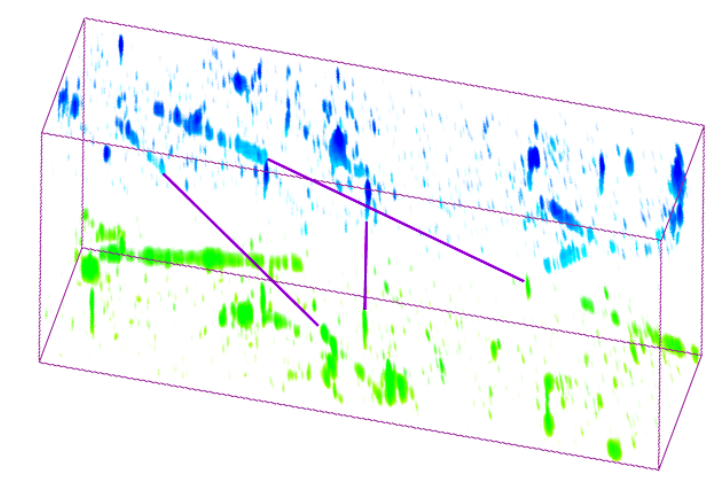
Figure 9. Tomographic data acquired by the microscope for a small volume of 150 µ m × 30 µ m × 300 µ m. Blue and green colors refer to the top and bottom of sensitive layers, respectively. Purple lines represent correlated tracks between the sensitive layers